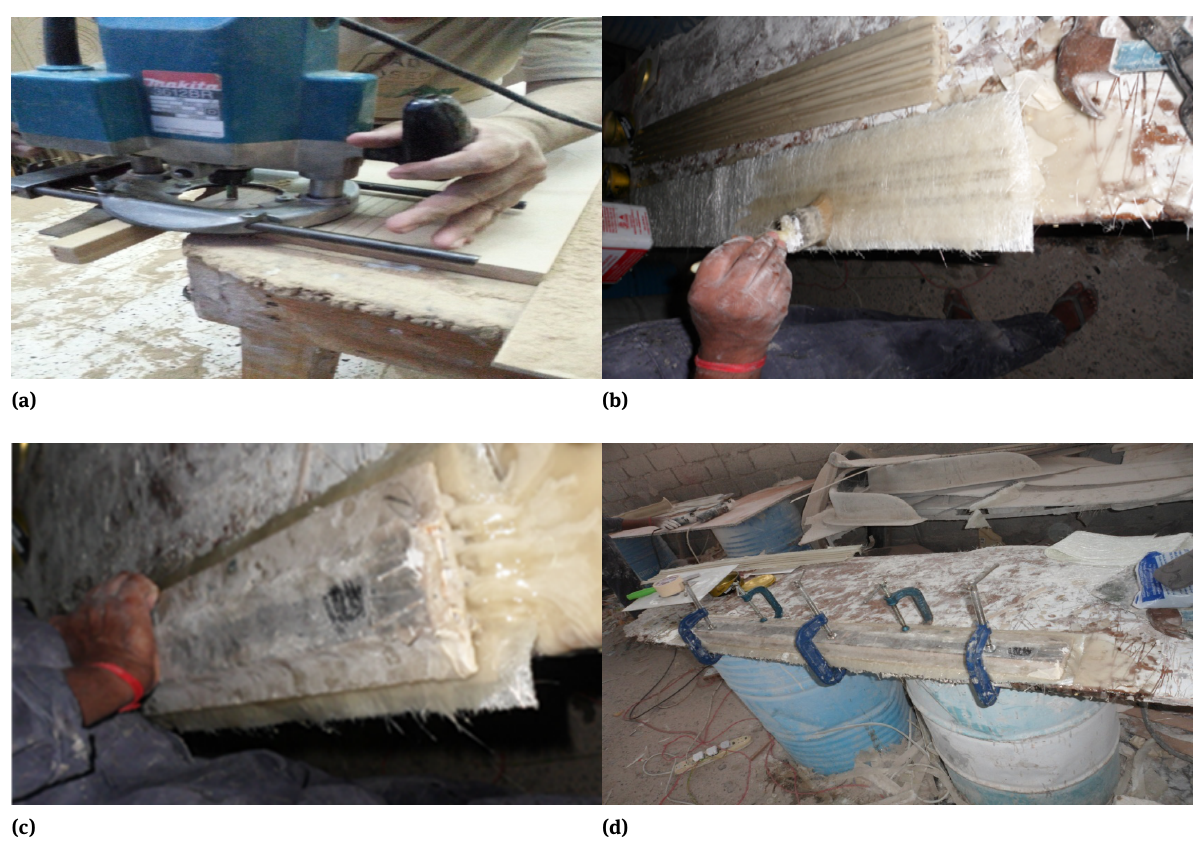
Figure 2: Fabrication of corrugated profile: (a) Preparation of wooden dye; (b) Placing GFRP sheet and application of resins on mould; (c) Placing of the second mould over GFRP sheet; (d) Clips used to hold the set-up in position.